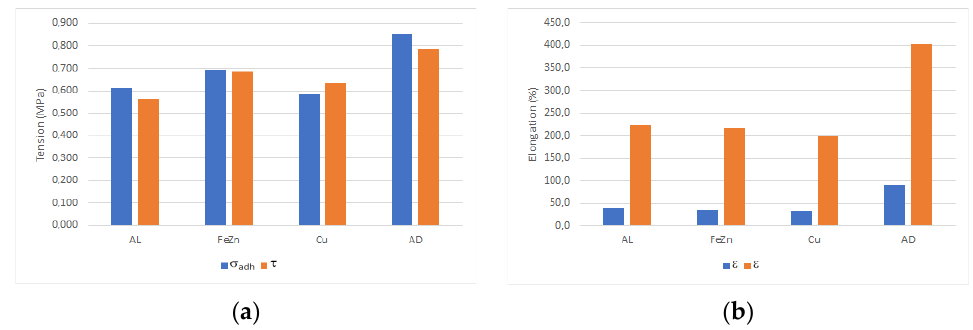
Figure 5. Comparison of test results: ( a ) σ adh (in MPa) for tensile test (blue) and τ (in MPa) for shear test (orange); ( b ) ε (in %) for tensile test (blue) and shear test (orange).